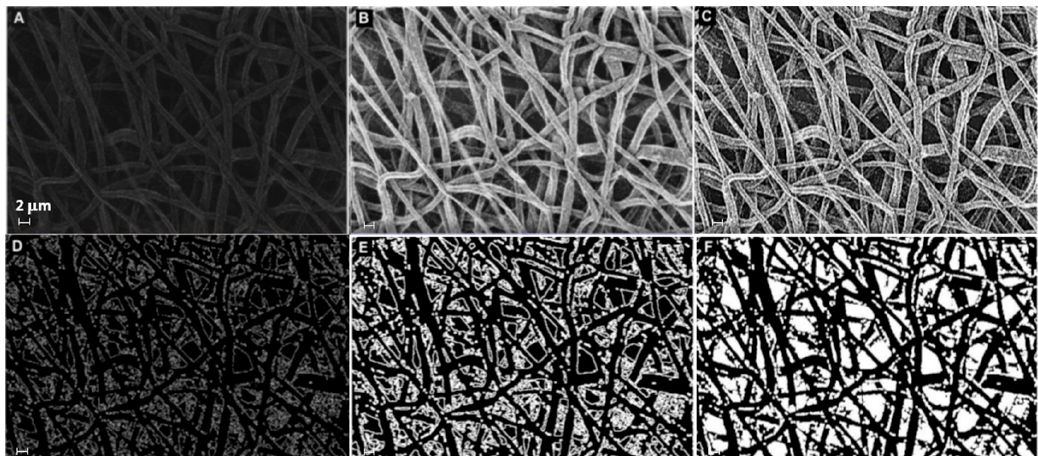
Figure 1. Sequence of image processing using MATLAB functions to prepare the input file for DiameterJ: ( A ) original SEM, ( B ) applied “histeq” and “medfilt2” functions, ( C ) applied “imsharpen”, “smoothing”, and “cleaning” functions, ( D ) applied “find edge” function, ( E ) applied “imdilate” function, ( F ) performed “imfill” function using ImageJ (scalebar is the same and equal 2 μ m for all panels).